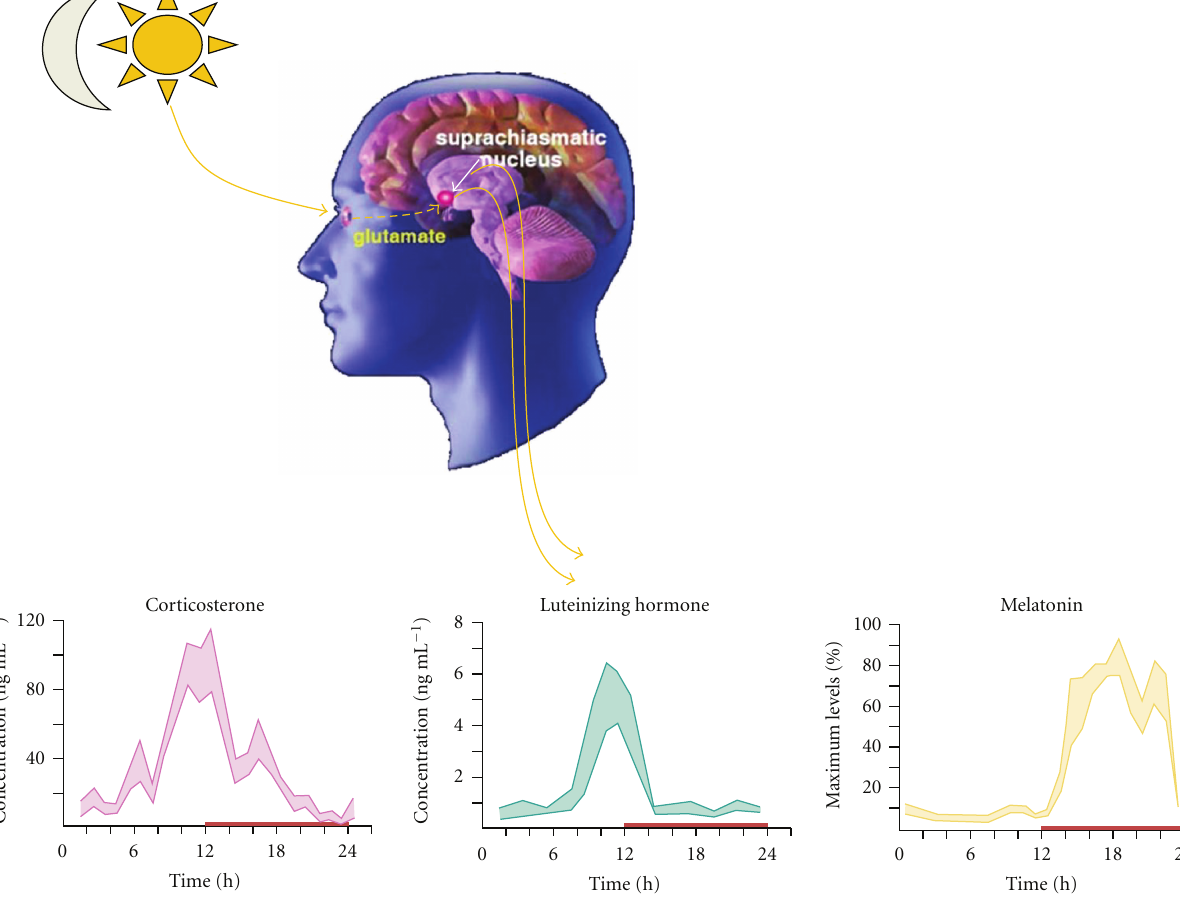
Figure 2: Targets of the SCN. The temporal signal transmitted by the suprachiasmatic nucleus, the biological clock, is translated into a rhythmic hormonal pattern or signals provided by the autonomic system. This relationship provides information to the body that adjusts peripheral organs to the light-dark cycle. The bottom panel shows the circadian rhythm in blood levels of corticosterone, luteinizing hormone, and melatonin for rodents modified from